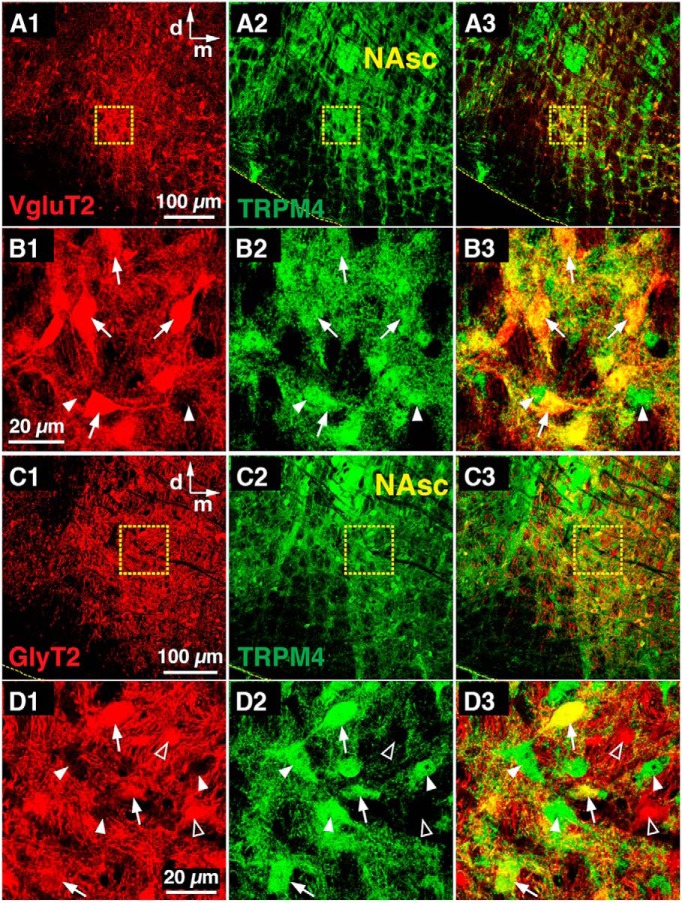
Glutamatergic and glycinergic pre-BötC neurons express TRPM4 channels. A, Confocal fluorescence microscopy single plane images of a coronal section of the medulla at the level of the pre-BötC ventral to NAsc from adult VgluT2-tdTomato transgenic mouse, showing Cre-dependent tdTomato-labeled glutamatergic neurons (red, A1), TRPM4 antibody-labeled neurons (green, A2) throughout the pre-BötC, and their merged image (A3). B, Single optical plane images of VgluT2 positive (B1) and TRPM4 (B2) immunolabeled neurons in the pre-BötC subregion marked by dashed box in A. Merged image (B3) shows that a majority of VgluT2-positive pre-BötC neurons were colabeled with TRPM4 antibody (white arrows) along with TRPM4 antibody-positive, but VgluT2-negative, neurons (arrowheads). C, Confocal images of the pre-BötC region from adult GlyT2-tdTomato transgenic mouse showing Cre-conditional tdTomato-labeled glycinergic neurons (red, C1), TRPM4 antibody-labeled neurons (green, C2), and the merged image (C3). D, Single optical plane images of GlyT2-positive (D1) and TRPM4 immunolabeled neurons (D2) in the pre-BötC area marked by dashed box in C. Merged image (D3) shows GlyT2-positive pre-BötC neurons colabeled with TRPM4 antibody (white arrows) along with TRPM4 antibody-positive, but GlyT2-negative, neurons (arrowheads) as well as TRPM4 antibody-negative, GlyT2-positive neurons (open arrowheads). All images have the same dorso-medial anatomic orientation. NAsc, semi-compact division of nucleus ambiguus; d, dorsal; m, medial.